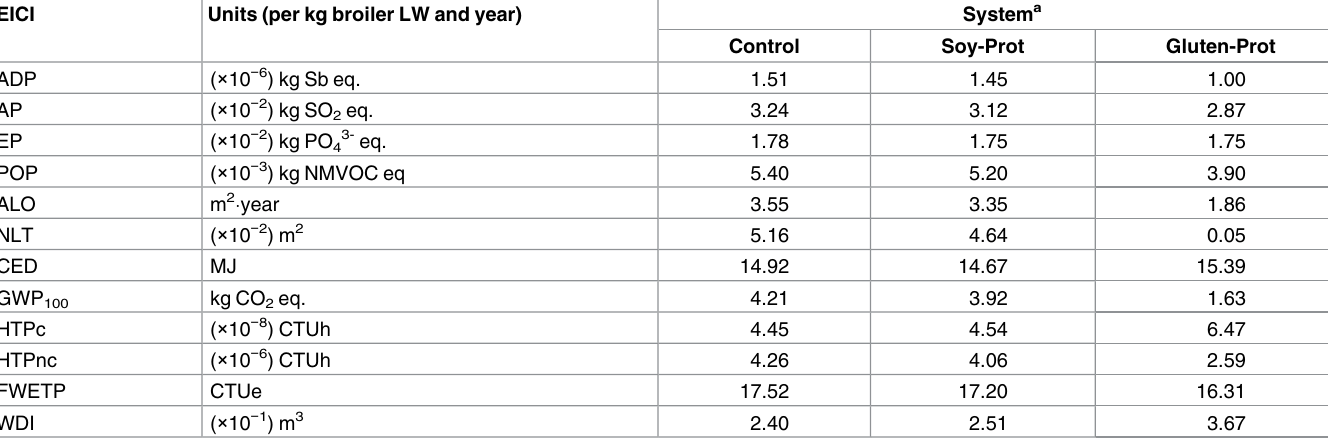
Table 10. Potential environmental impacts per kg of broiler LW at the farm gate and year for the three different systems examined. EICI Units (per kg broiler LW and